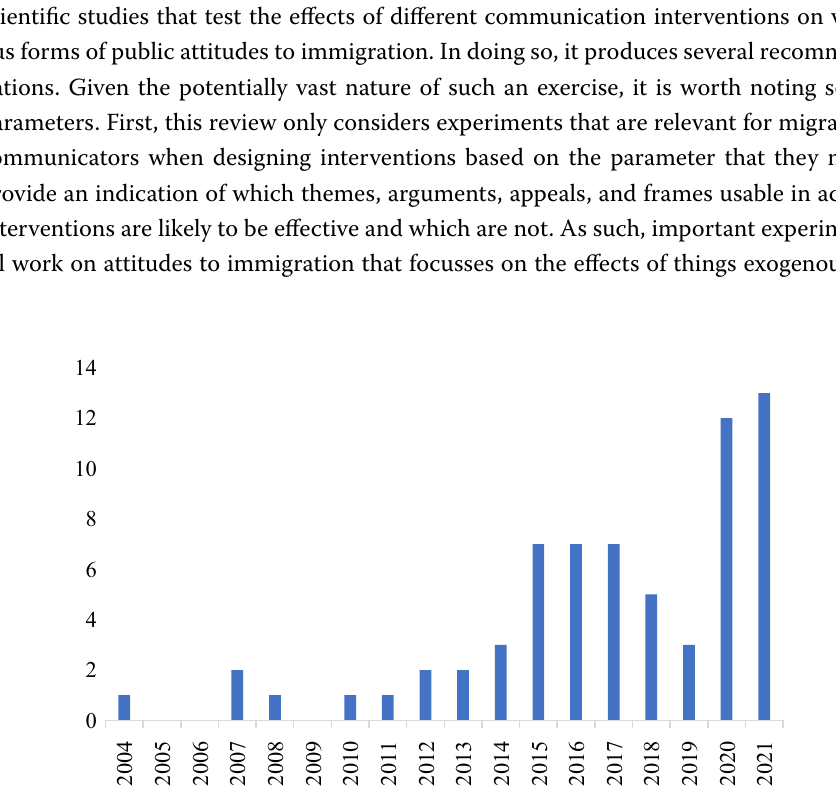
Fig. 1 Year of publication of reviewed experimental studies on the effect of communication interventions on attitudes to